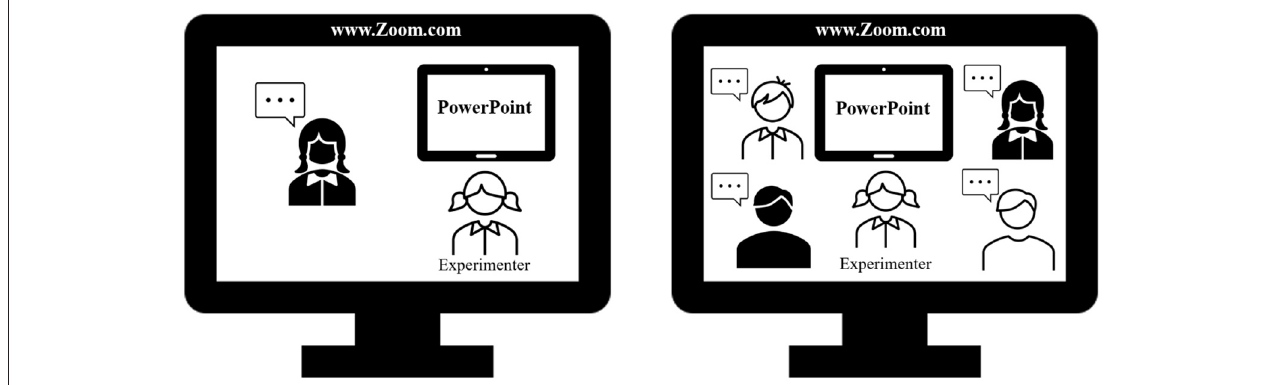
FIGURE 1 | Sketch of the Zoom video call setting for the single-person (left) and the small group (right) recall conditions. Clip art is from Microsoft PowerPoint, version 16.50 (Microsoft